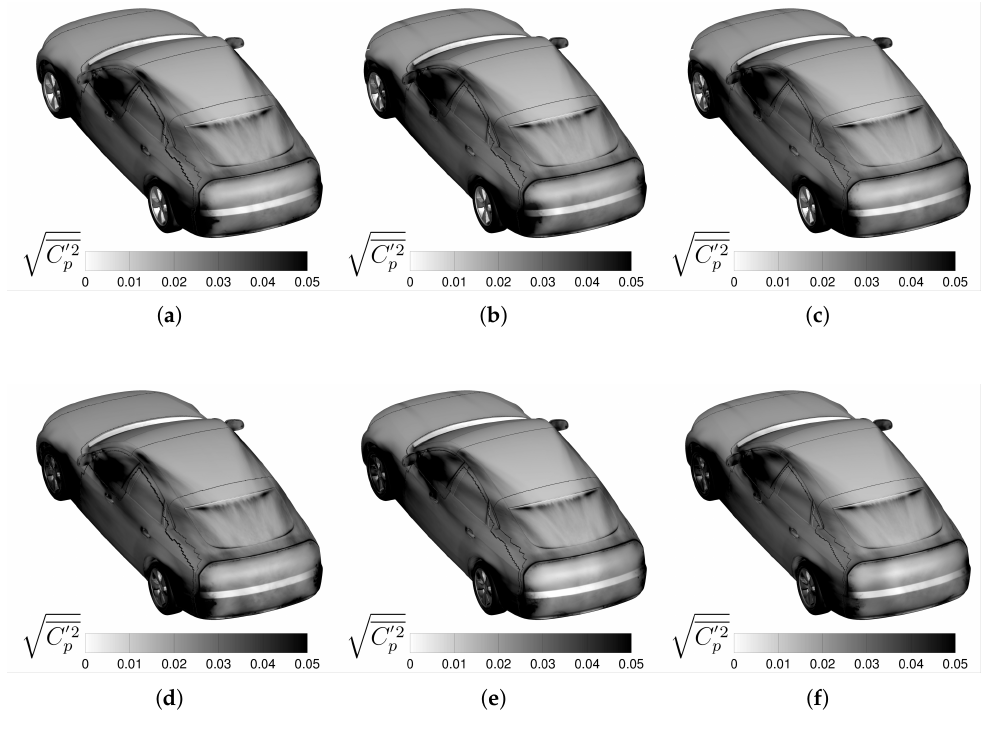
(cid:113) C (cid:48) p for the ( a ) coarse